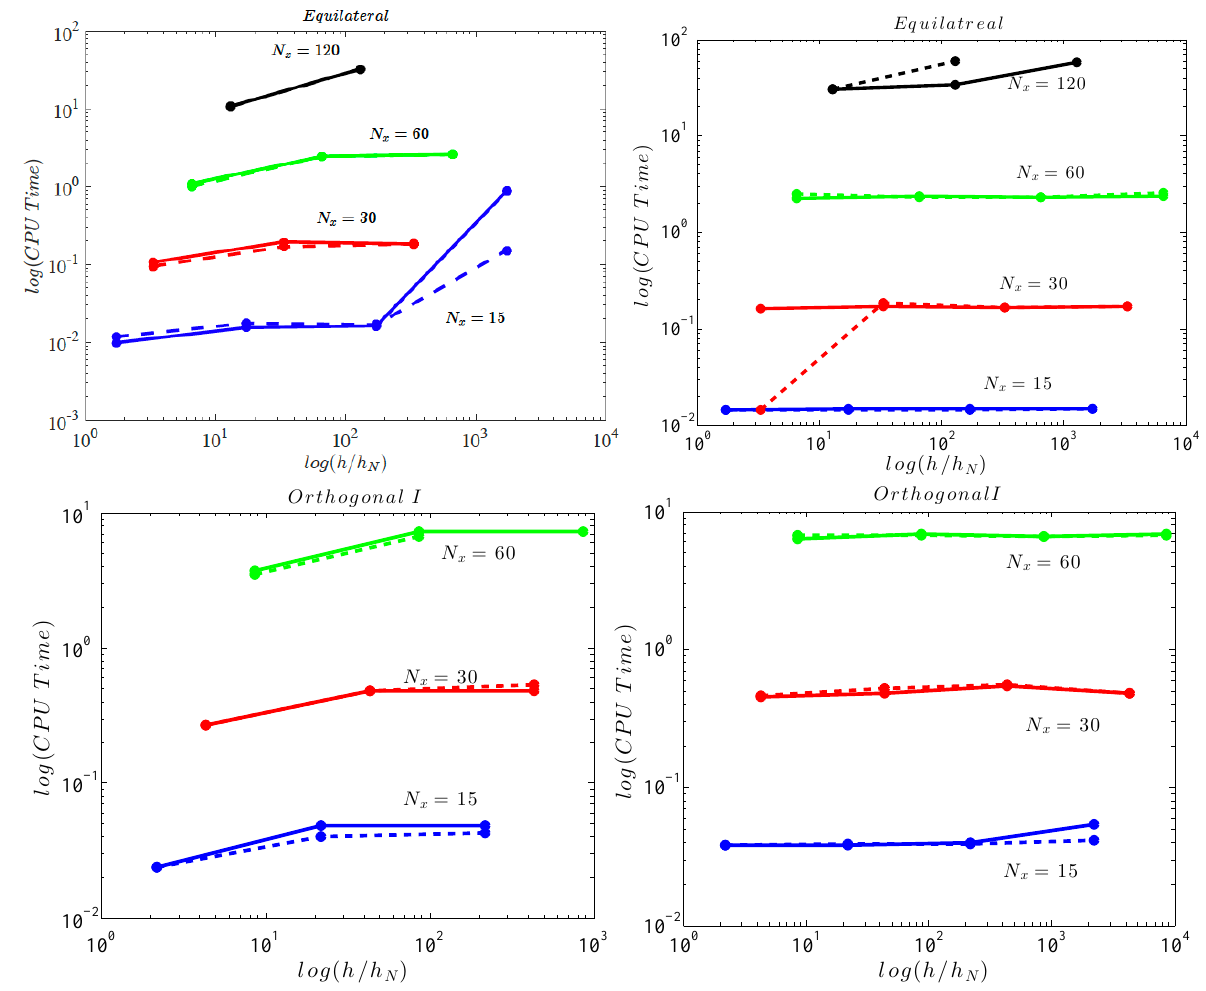
Figure 10. CPU time versus variable water depth for GMRES (solid line) and BiCGStab (dashed line) using ILUT preconditioner with threshold 10 − 5 ( left ) and 10 − 10 ( right ) and CMK reordering, for Equilateral type of grid ( up ) and for Orthogonal I ( down